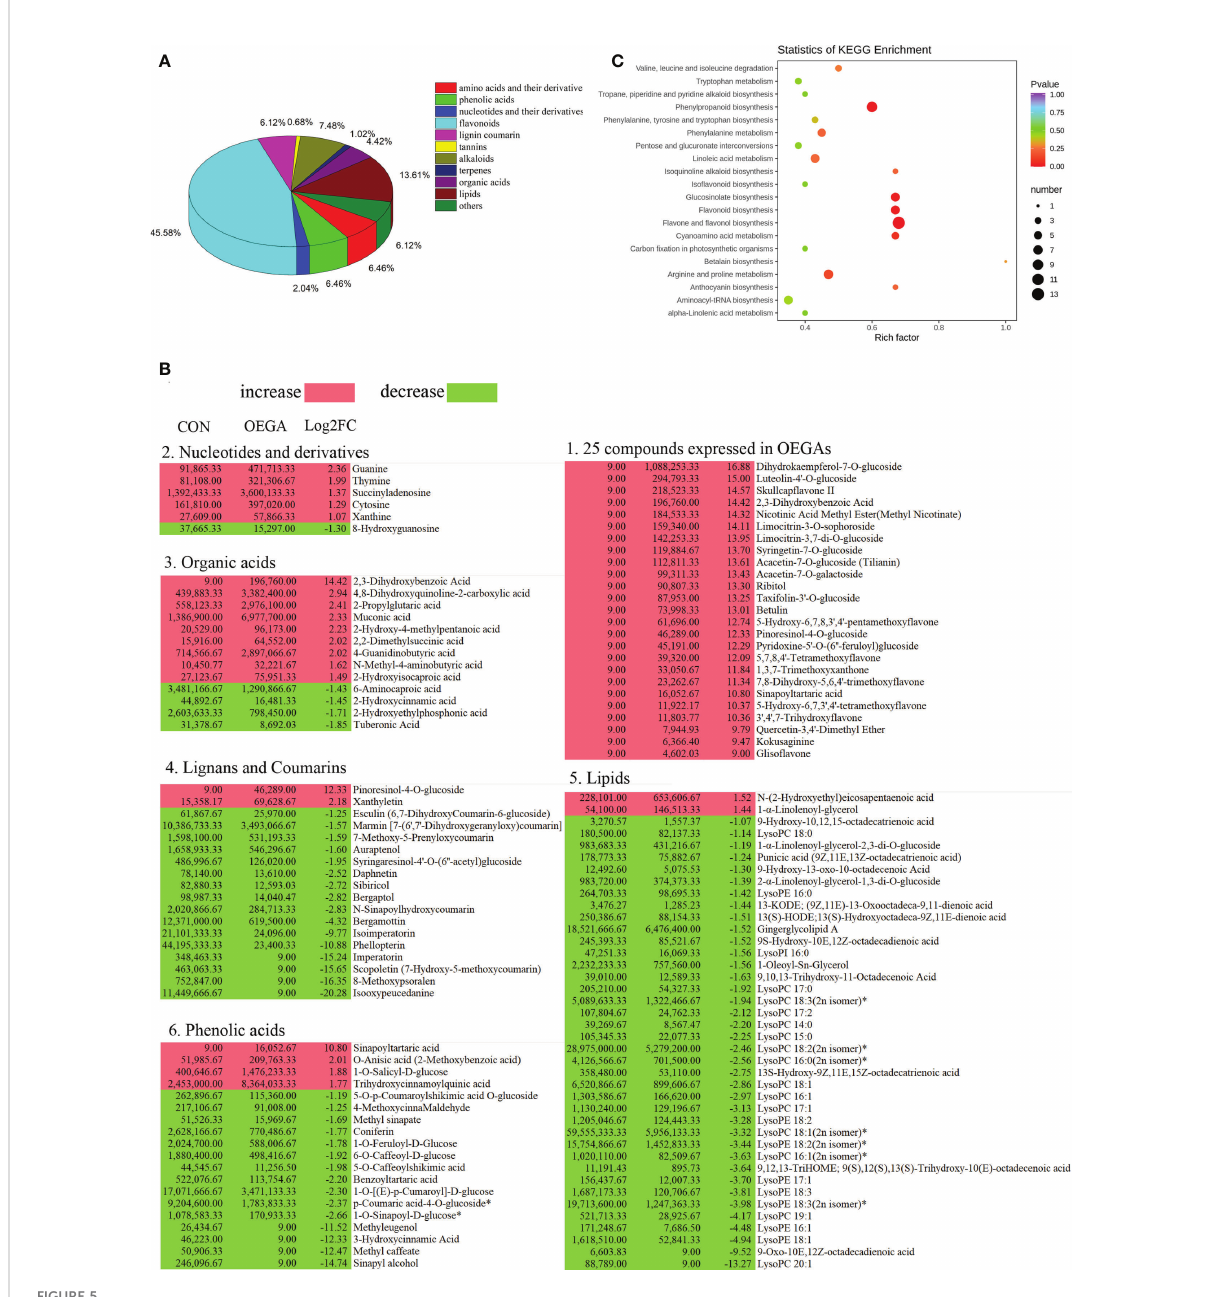
FIGURE 5 Pathway enrichment analysis of the differential metabolites in the OEGA transgenic citrus. (A) Classi fi cation and proportion of the differentially- accumulated metabolites. The numbers next to the pie chart represent the percentage of different types of DAMs among the total differential metabolites. (B) Abundance of the signi fi cant DAMs among the different metabolite classes. Red and green indicate increased and decreased levels of metabolites, respectively, as indicated by the colored squares. Lysophosphatidylcholine, LysoPC; lysophosphatidylethanolamine, LysoPE. (C) Signi fi cantly-enriched KEGG metabolic pathways. The abscissa indicates the enrichment factor, and the ordinate indicates the enrichment pathway. The dot sizes represent the number of differentially-enriched metabolites. The greater the rich factor, the greater the degree of enrichment. The larger the point, the greater the number of differentially-enriched metabolites in the pathway. The signi fi cance of the enrichment level is indicated by the color of the dot according to the color scheme shown on the